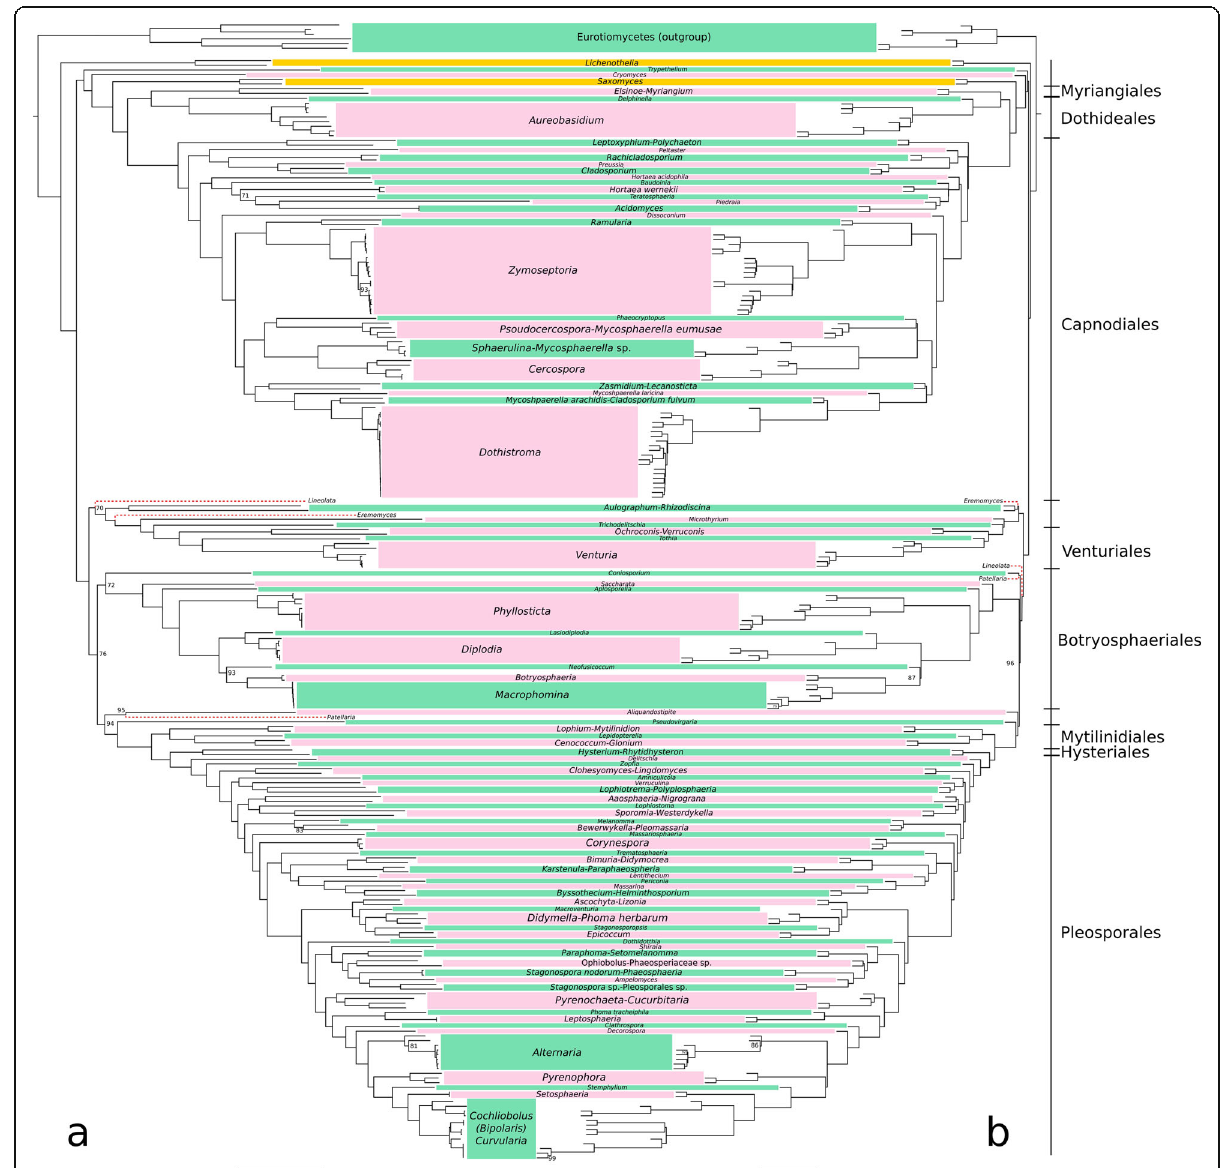
Fig. 2 Phylogenomic inferences based on the concatenated supermatrix ( a ) and multispecies coalescent ( b ) approaches. The dataset was composed by 664 single-copy gene regions longer than 1 Kb (after alignment trimming with Gblocks). Topology mismatches between the phylogenies are highlighted by red dashed branch lines. Bootstrap support values lower than 100% are shown. Lichenothelia and Saxomyces clades are highlighted by orange boxes. Pink and green boxes alternatively delimit the other lineages, either represented by a single genus or by multiple